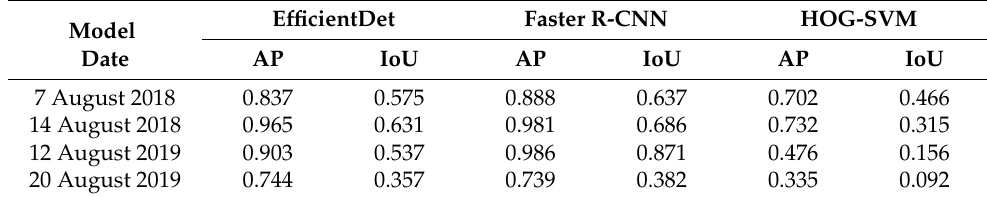
Table 8. Evaluation of model performance on four datasets.